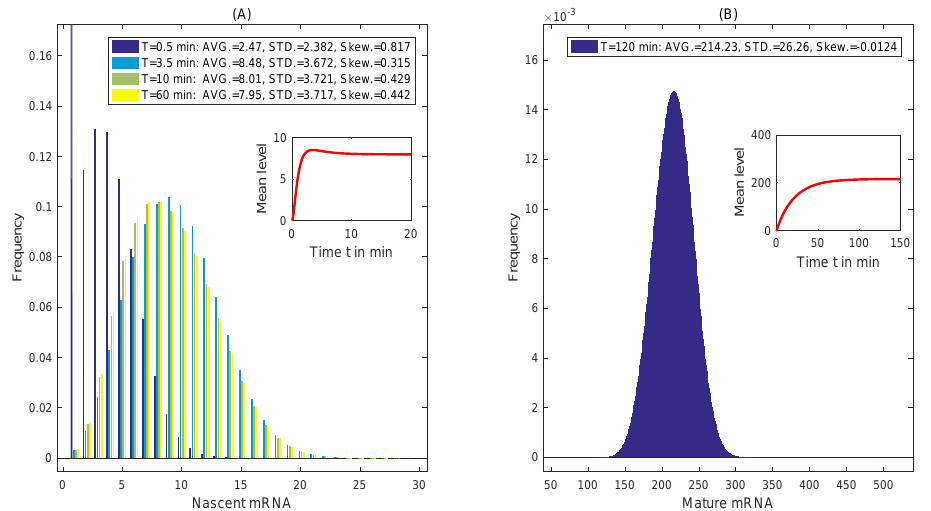
Figure 5. ( A ) The distribution of nascent mRNAs when ν 1 > ν 2 at different times; ( B ) the distribution of mature mRNAs when ν 1 > ν 2 at T = 120 min. Parameters are given in (30).